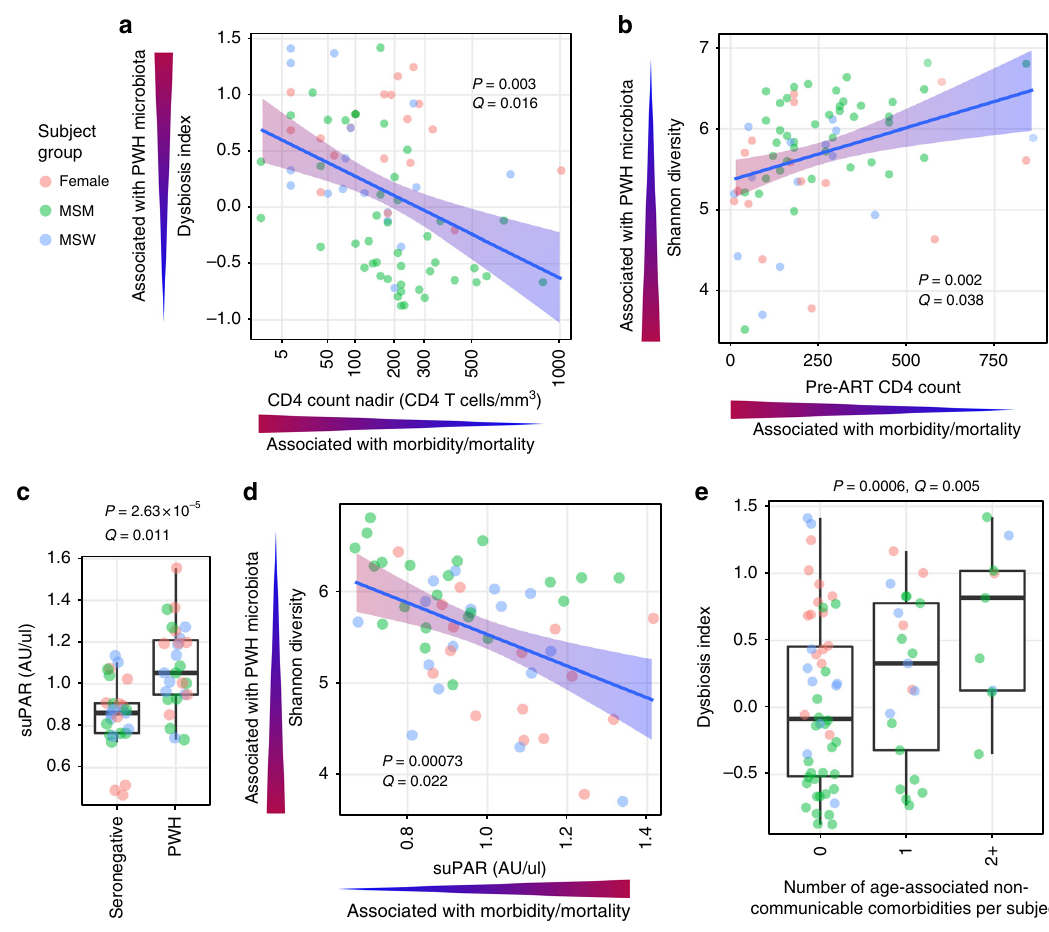
Fig. 6 HIV-associated gut microbiota features correlate with markers of HIV disease progression, immune activation, as well as comorbidity prevalence. Linear mixed effects (LME) models were used to control for subgroup (F, MSM, MSW) as random effects for all analyses depicted. Linear regression lines denoted in blue with 95% con fi dence intervals depicted as a gradient with red representing directions for both independent and dependent variables that are associated with the PWH state (e.g. high dysbiosis index, low nadir CD4 count) and blue representing the seronegative state. a ‘ Dysbiosis Index ’ (DI) correlates with nadir CD4 (count/mm 3 ), LME P = 0.003, Benjamini – Hochberg Q = 0.017, among PWH subjects ( n = 80). b Shannon alpha diversity correlates with pre-ART CD4 count, LME P = 0.002, Q = 0.038. c suPAR concentrations in plasma are strongly elevated in PWH ( n = 27) compared